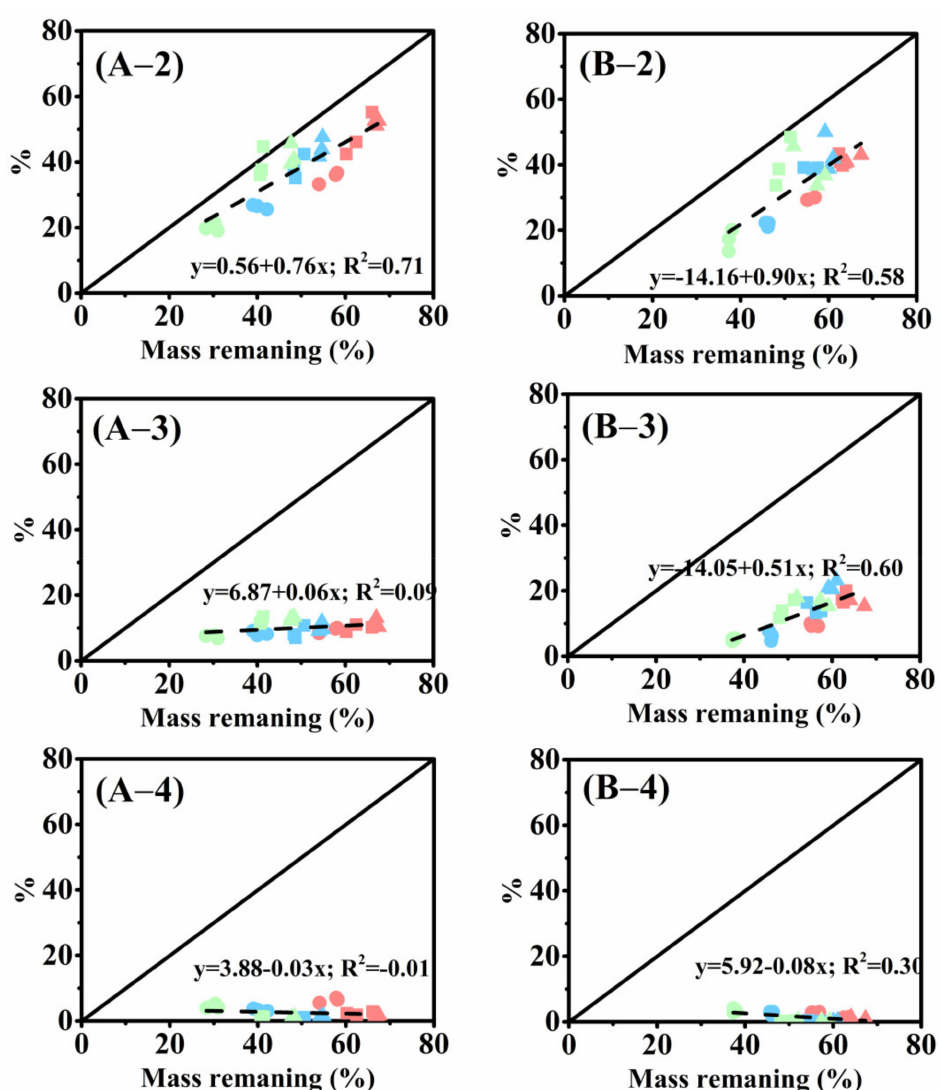
Figure 4. Relationship between percent litter mass remaining and percent C, N, P, and K mass remaining in E. crusgali and B. tripartita . ( A–1 ) C in E. crusgali ; ( A–2 ) N in E. crusgali ; ( A–3 ) P in E. crusgali ; ( A–4 ) K in E. crusgali ; ( B–1 ) C in B. tripartita ; ( B–2 ) N in B. tripartita ; ( B–3 ) P in B. tripartita ; ( B–4 ) K in B. tripartita . Symbols represent sediment burial treatments, whereas colors represent collection dates. In each figure, regression lines are dashed, and the 1:1 line is